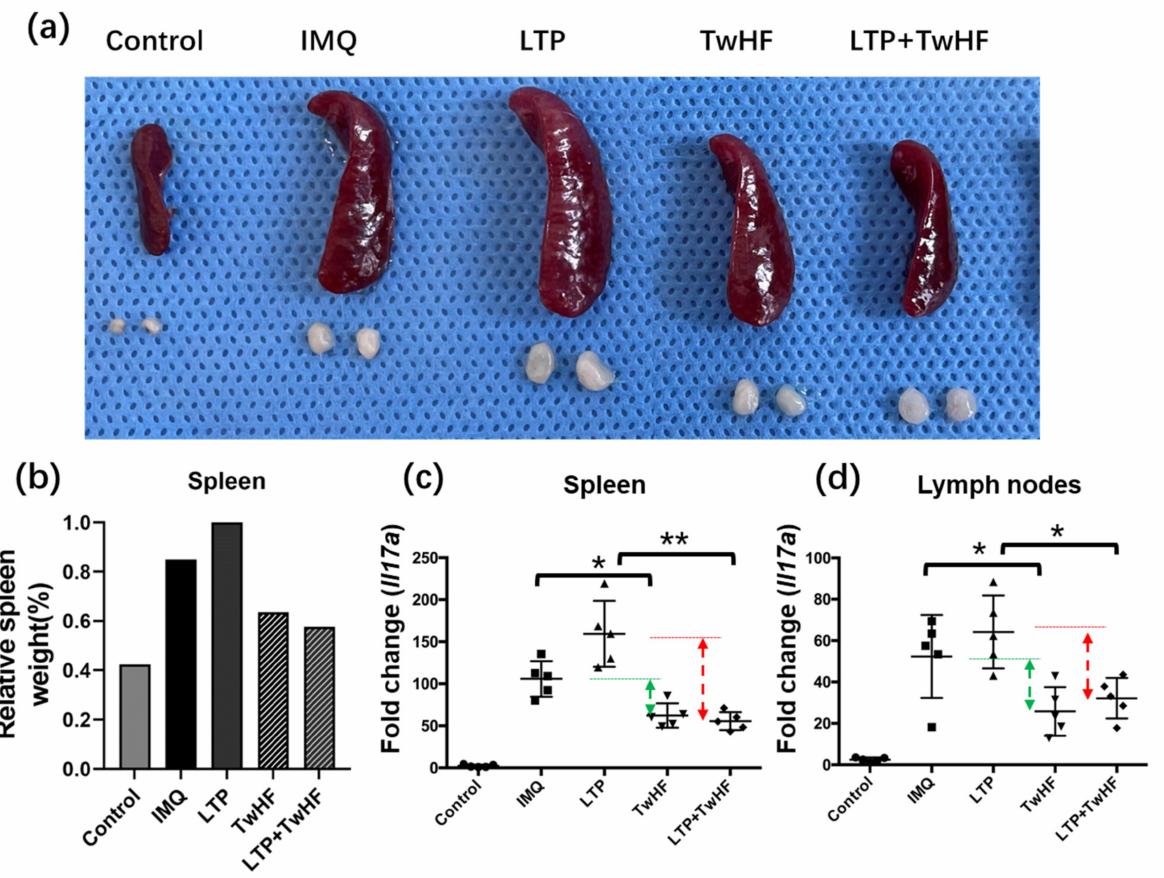
Figure 10. LTP + TwHF suppressed IMQ-induced systemic inflammation. ( a ) Photos of spleen and skin draining lymph nodes taken on the 7th day after IMQ painting. ( b ) Relative weight of spleen of the control and treatment group. The largest spleen of the LTP case is chosen as 100%. ( c , d ) The mRNA levels of Il17a in the spleen and axillary lymph nodes. ( n = 5 mice). * p < 0.05 and ** p <